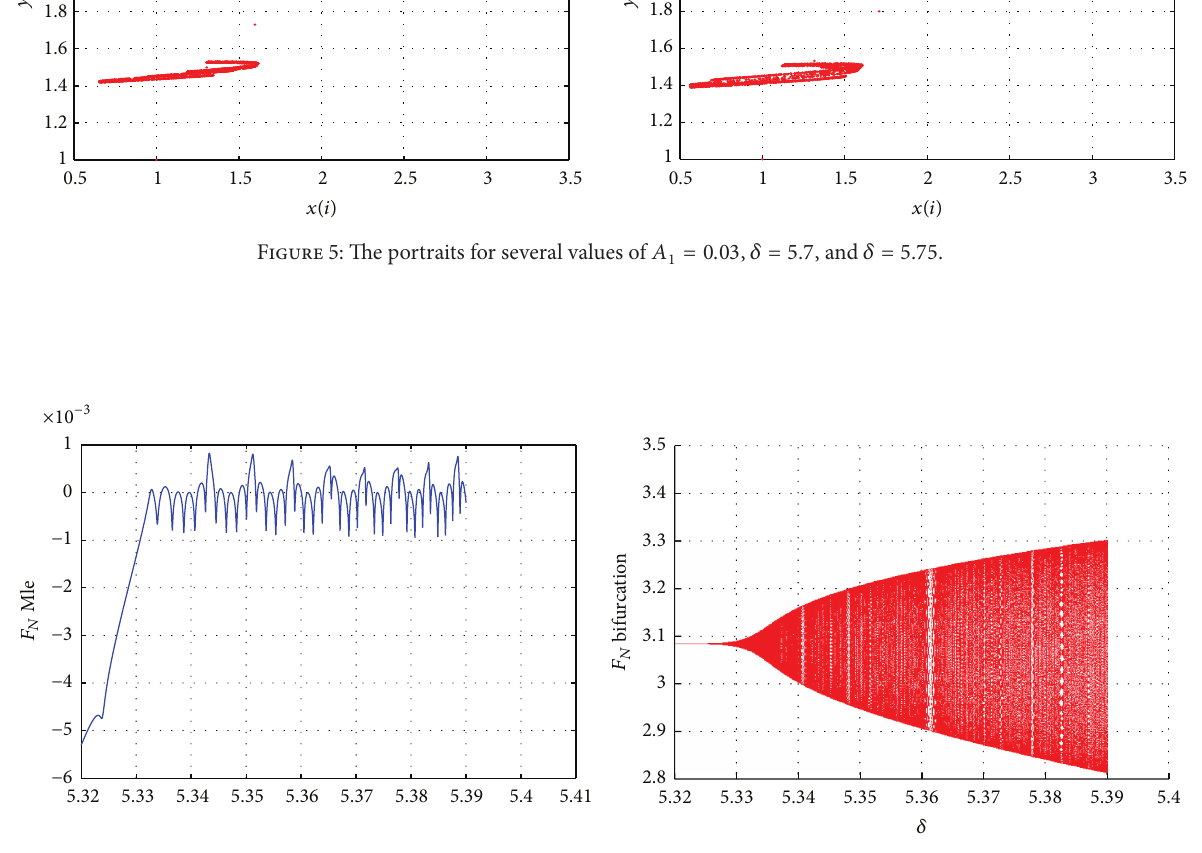
Figure 6: Largest Lyapunov exponents and bifurcation diagram of system (25) for 𝑎 = 0.8 , 𝑏 = 0.8 , 𝑐 = 0.4 , 𝑑 = 0.2 , 𝑘 = 5 , 𝑙 = 3 , and = 0.18 with the initial value of (𝑥,𝑦) = (1,1) and 𝛿 covering [5.32, 5.39] . 𝐴 1